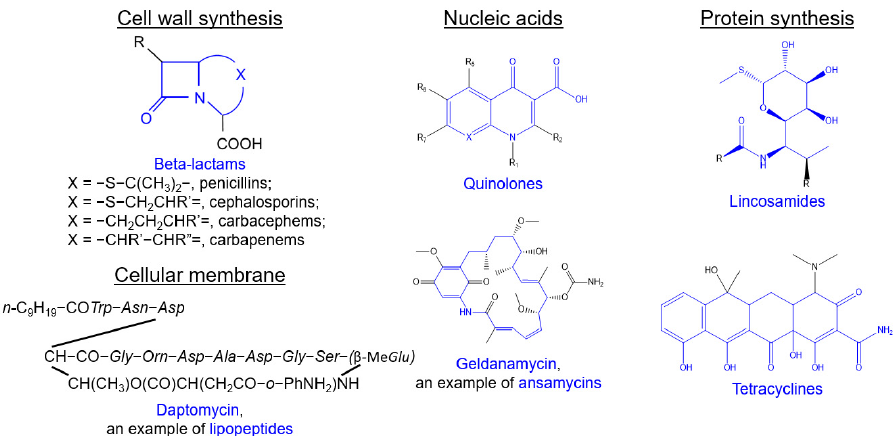
Figure 3. The chemical structures of various antibiotic classes juxtaposed with their biochemical target names (the structural motifs typical for the antibiotic classes are shown in blue).